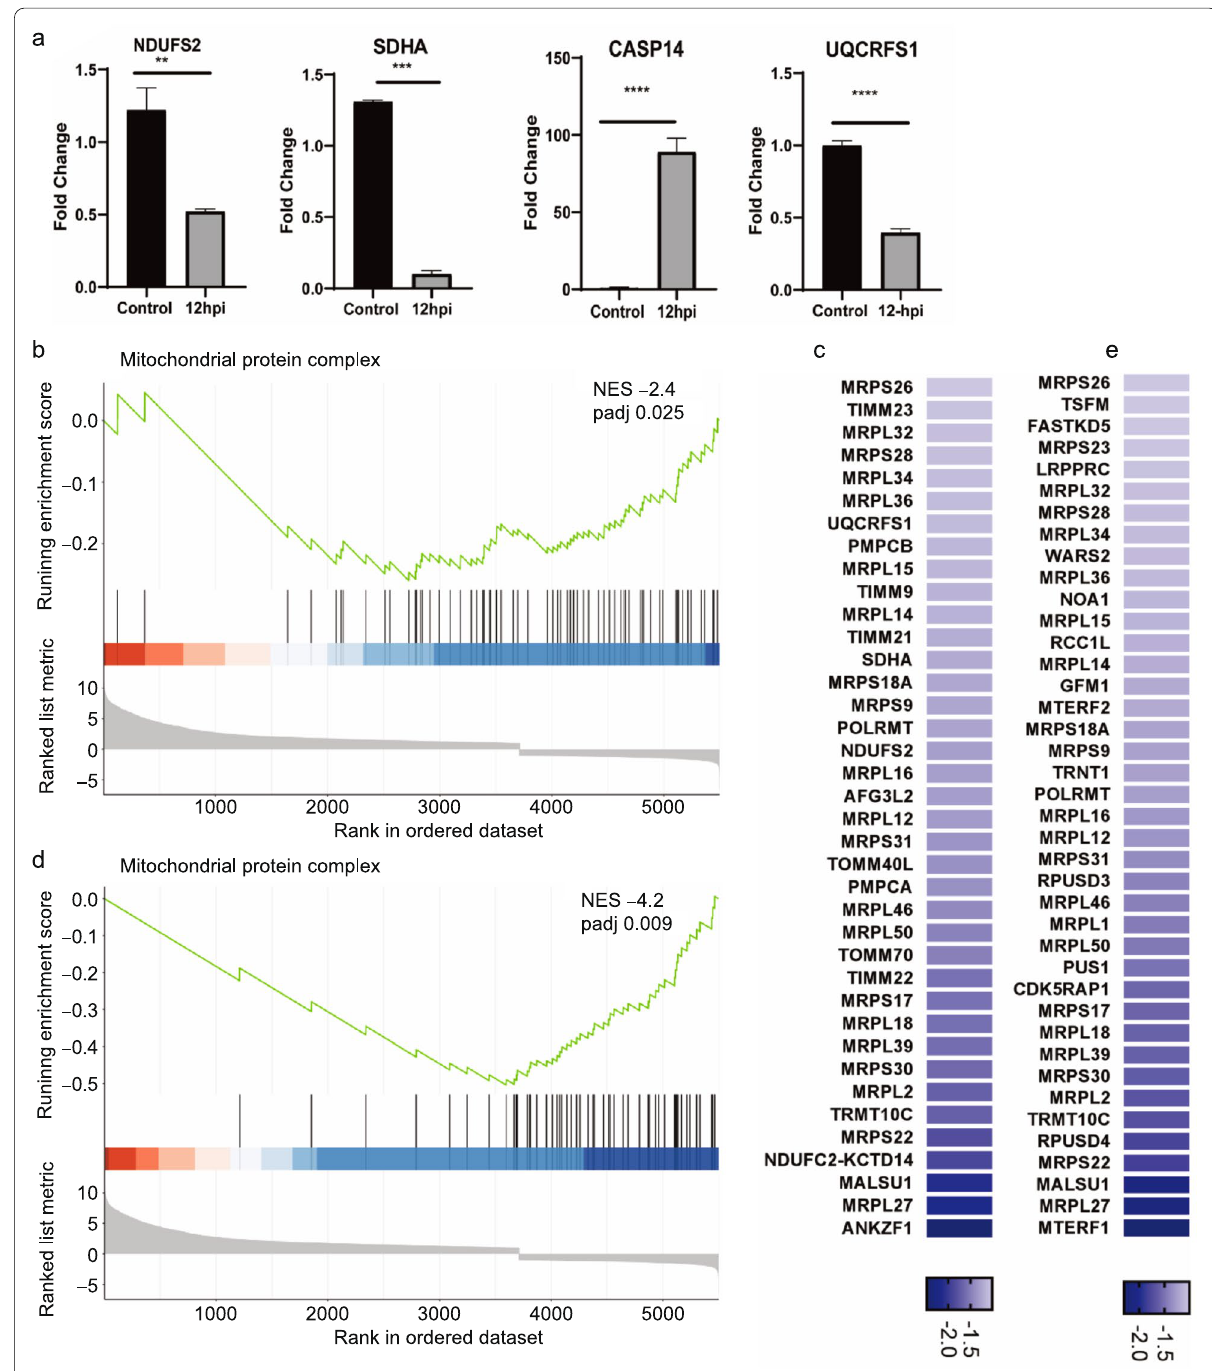
Fig. 10 Altered mitochondrial gene expression of human brain microvascular endothelial cells (hBMECs). a quantification of gene expression by (RT-qPCR) showing the fold change increase or decrease for four mitochondrial genes expression NDUSF2 , SDHA , CASP14 and UQCRFS1 within the infected hBMECs cells at 12 hpi compared to the control cells. statistical-significance analyzed by t-test * p < 0.05, ** p < 0.01, *** p < 0.001, and **** p < 0.0001. b the GSEA running enrichment score for the suppression of ‘mitochondrial protein complex’ (NES and c its top downregulated genes. d indicates the GESA plot for negative running enrichment score of ‘mitochondrial gene expression’ (NES padj 0.009) and e the top participating downregulated genes visualized in a heatmap. Black bars underneath the graph present the rank positions = of genes from the gene set, the green line refers to the enrichment